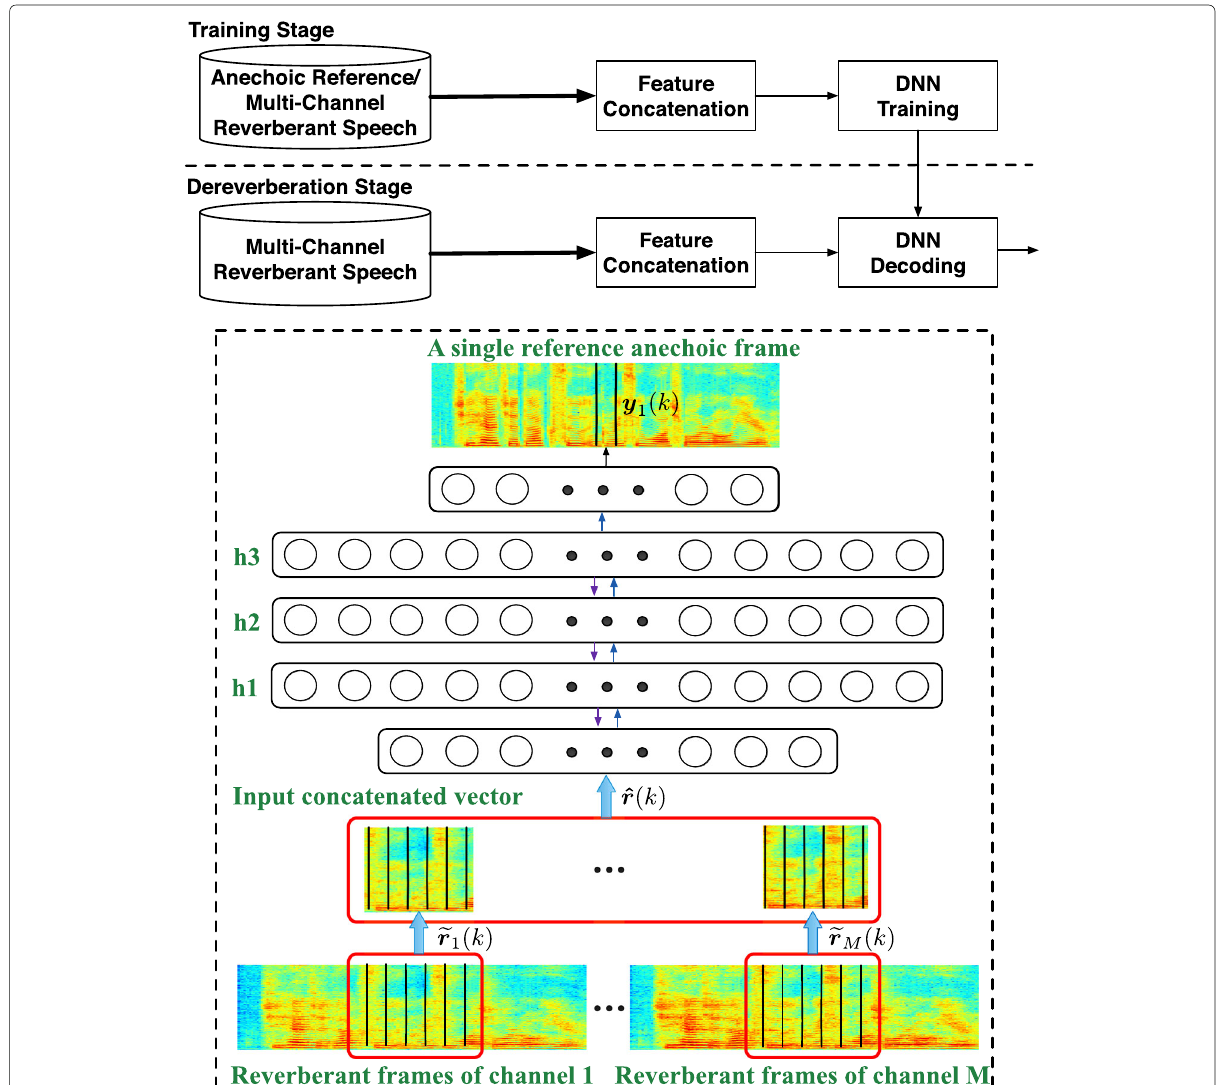
Fig. 3 A block diagram of the proposed DNNSpatial